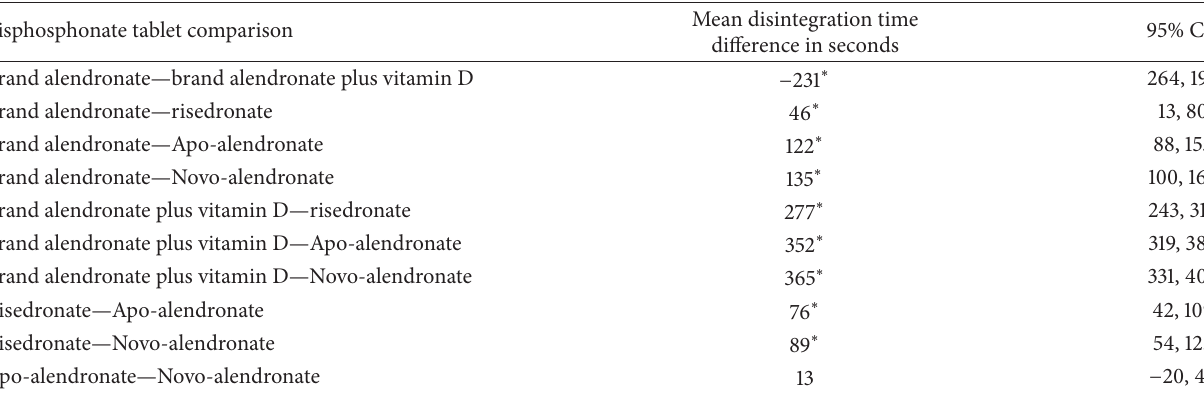
Table 2: Comparisons of mean disintegration times among brand and generic bisphosphonates.